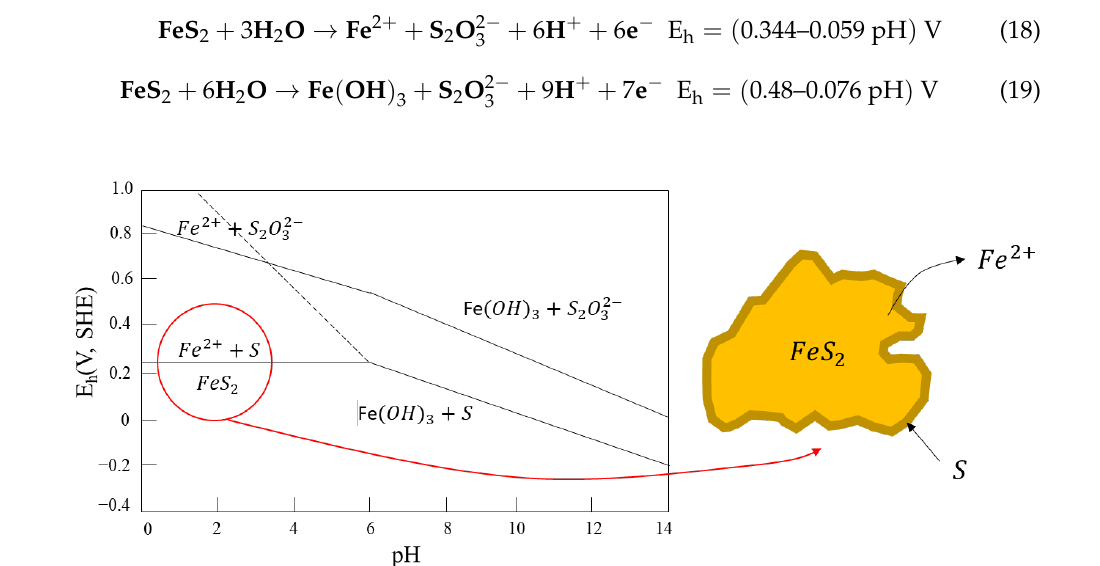
Figure 23. Eh-pH diagram for pyrite in aqueous solutions, with elemental sulfide as a meta-stable phase. The equilibrium lines correspond to species dissolved at 10 −4 mol/L (adapted from Hu et al. [111]).